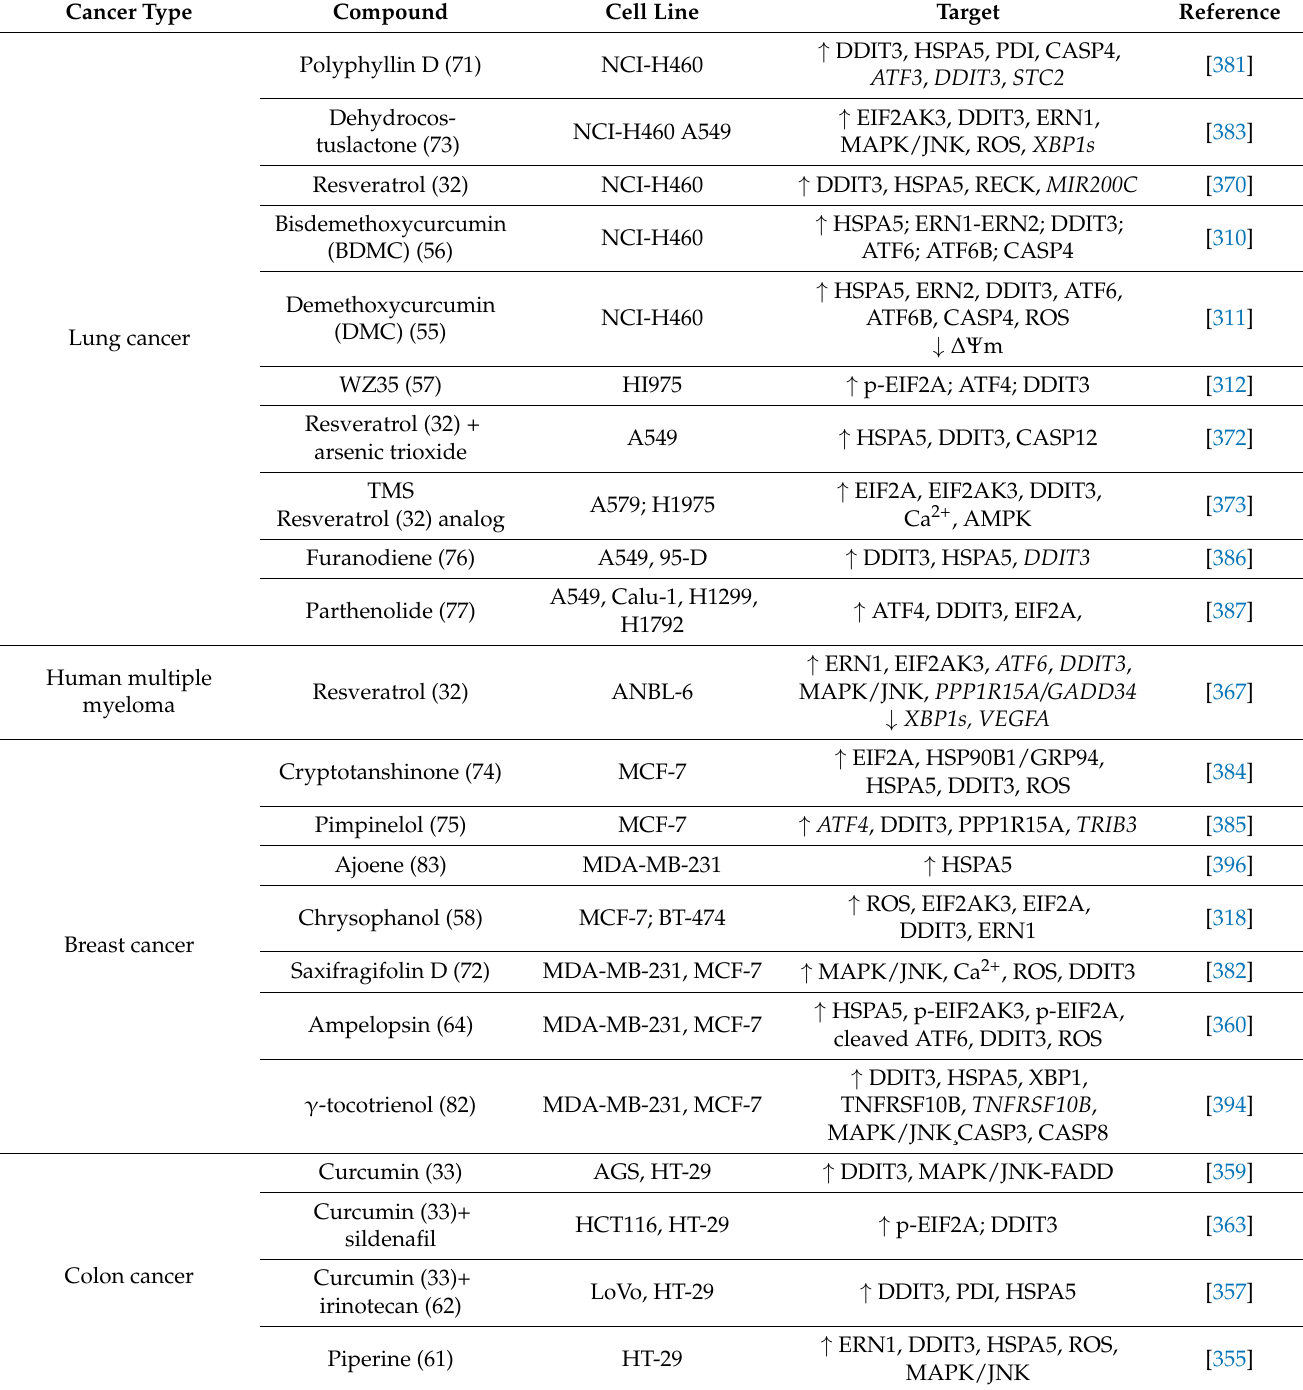
Table 3. Natural compounds with ER stress-mediated anti-cancer